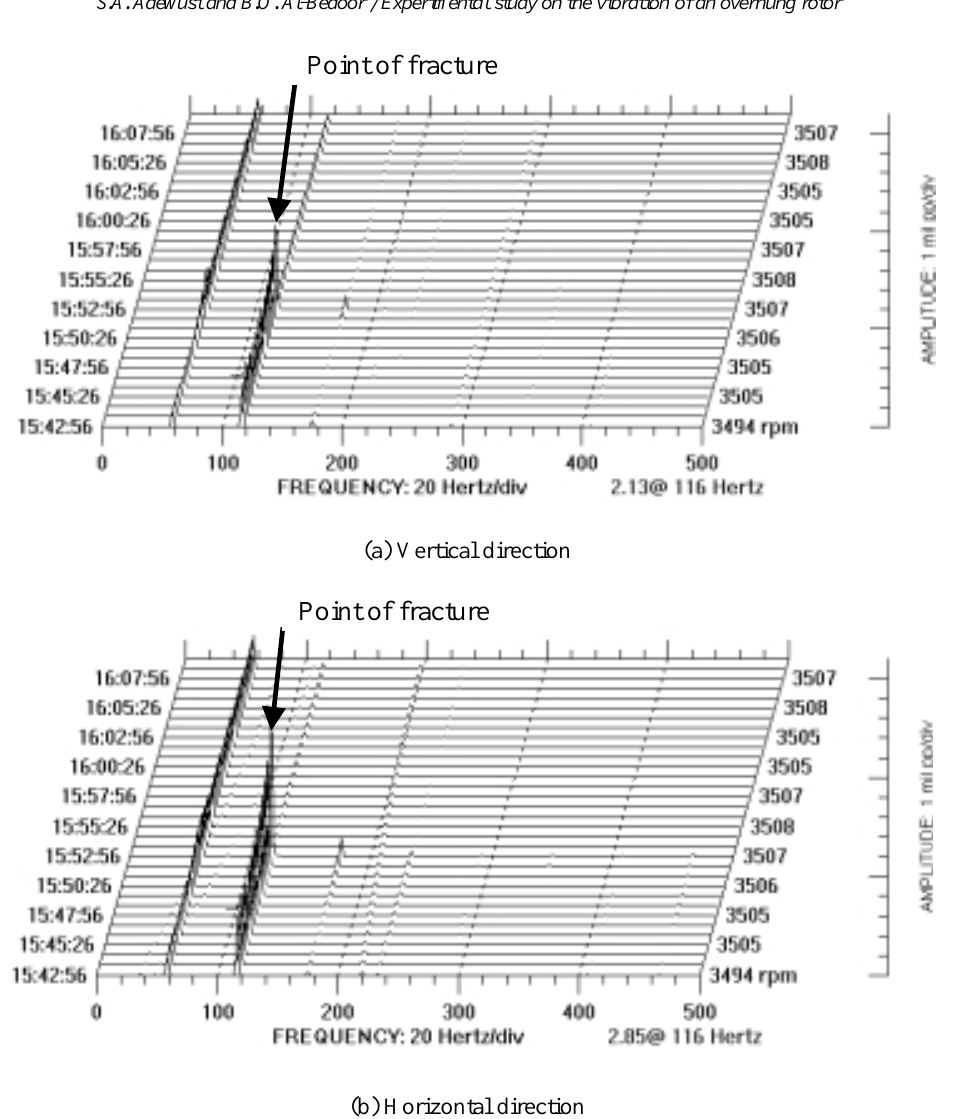
Fig. 8. Frequency waterfalls of steady state data for the 1st shaft with 4 mm notch crack and 8 kg vertical hanging side